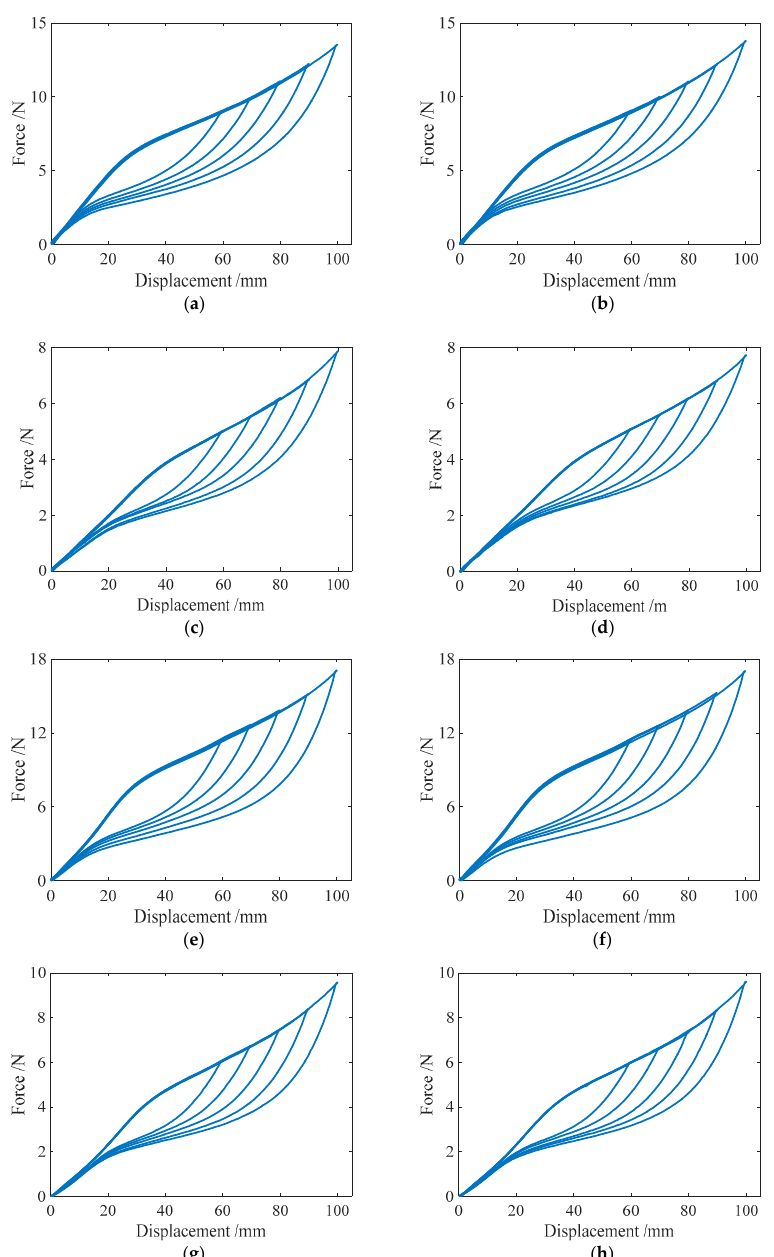
Figure 9. Force-displacement relationship curves for the spring specimens under cyclic loading with variable amplitudes: ( a ) SMA-S1 in Case I; ( b ) SMA-S1 in Case II; ( c ) SMA-S2 in Case I; ( d ) SMA-S2 in Case II; ( e ) SMA-S3 in Case I; ( f ) SMA-S3 in Case II; ( g ) SMA-S4 in Case I; ( h ) SMA-S4 in Case II.